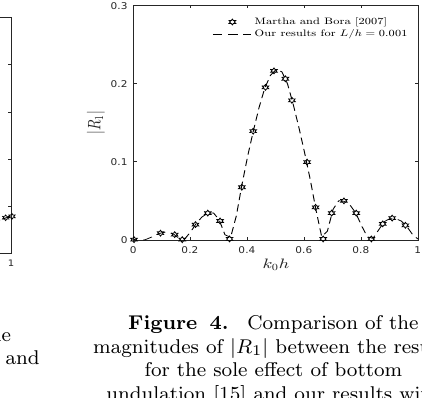
Figure 3. Comparison of the magnitudes of | R 1 | between rigid and elastic plates with D/h 4 = 10 ,l 1 /h = 0 . 001 ,l 2 /h = 0 . 1 ,M = 1 ,c 0 /h = 0 . 1 ,λh = 1 and m/h = 0 . 001.